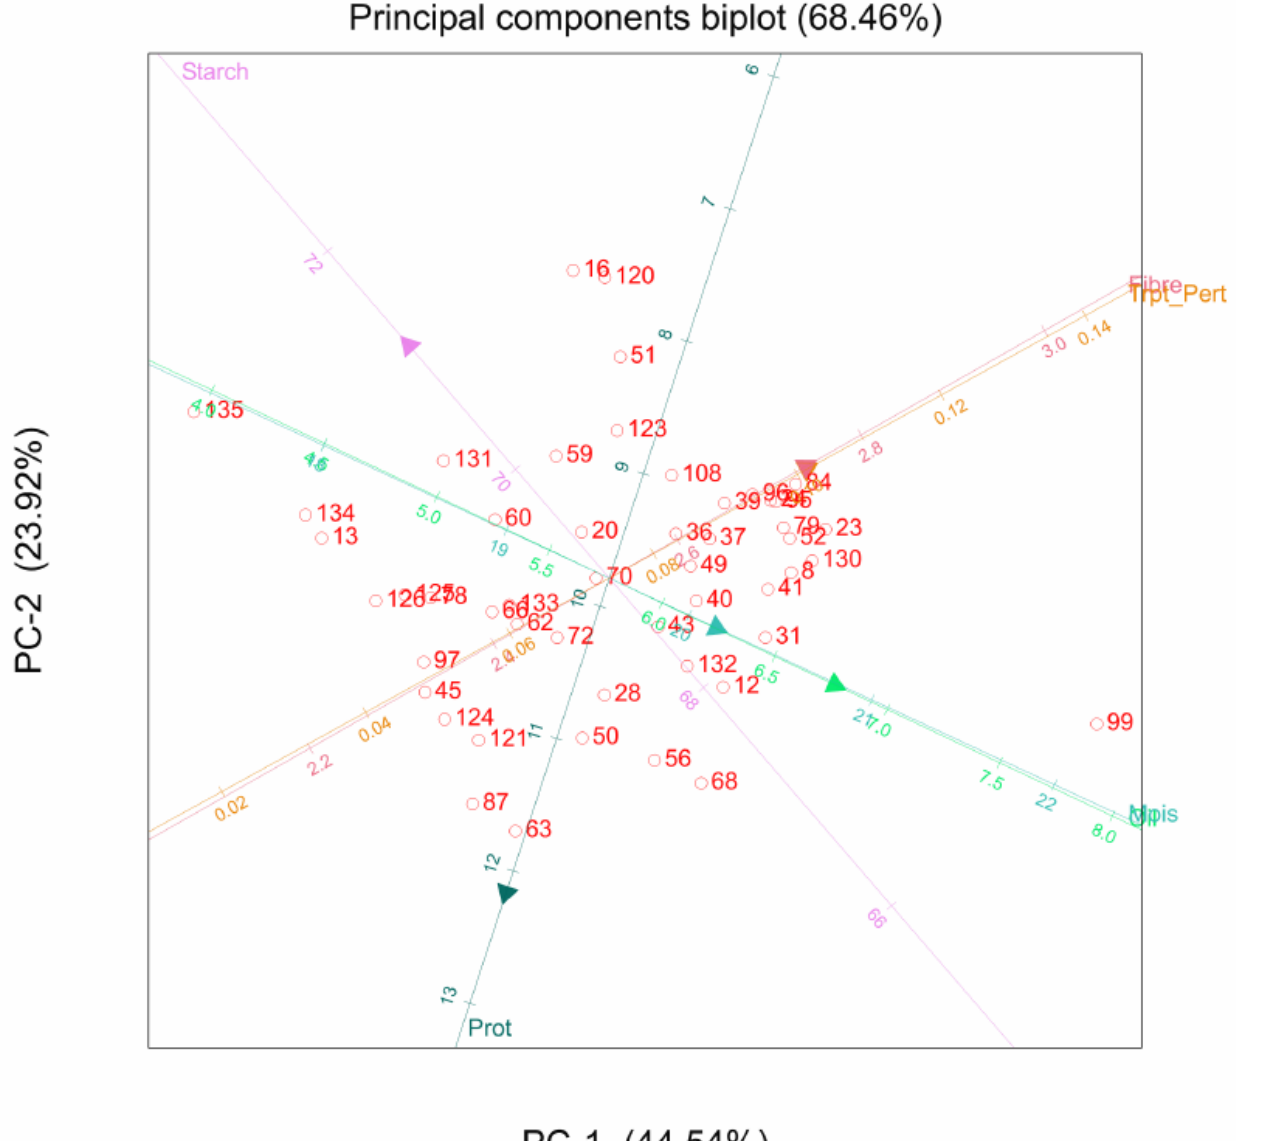
Figure 3. Combined principal component analysis biplot of 135 genotypes for grain yield, agronomic and quality traits: GY, grain yield; EPP, ears per plant; PH, plant height; EH, ear height; EASP, ear aspect; HC, husk cover; SL, stalk lodging; RL, root lodging; ASI, anthesis-silking interval; Trypt_Pert, tryptophan; Prot, protein.